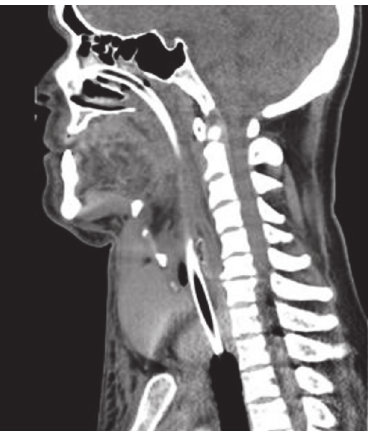
Figure 3: Arterial phase CT neck: parasagittal view of neck haematoma.